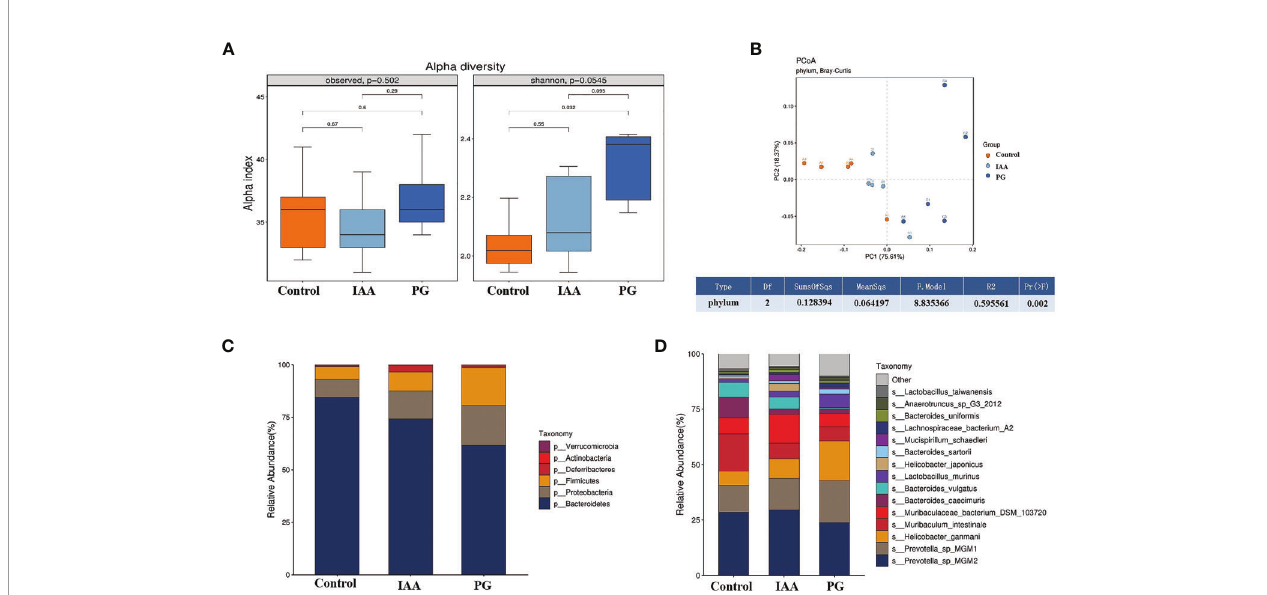
FIGURE 5 | IAA modulates the diversity and composition of the intestinal microbiota in AS mice. (A) Alpha diversity in three groups was assessed by observed species and Shannon index. (B) Beta diversity at the phylum level in three groups was assessed by principal coordinate analysis (PCoA) of Bray – Curtis dissimilarity paired with permutational multivariate analysis of variance (PERMANOVA). Relative abundance analyses of intestinal microbiota composition at the phylum (C) and species (D) levels in three groups. (n = 3). IAA, indole-3 acetic acid; AS, ankylosing